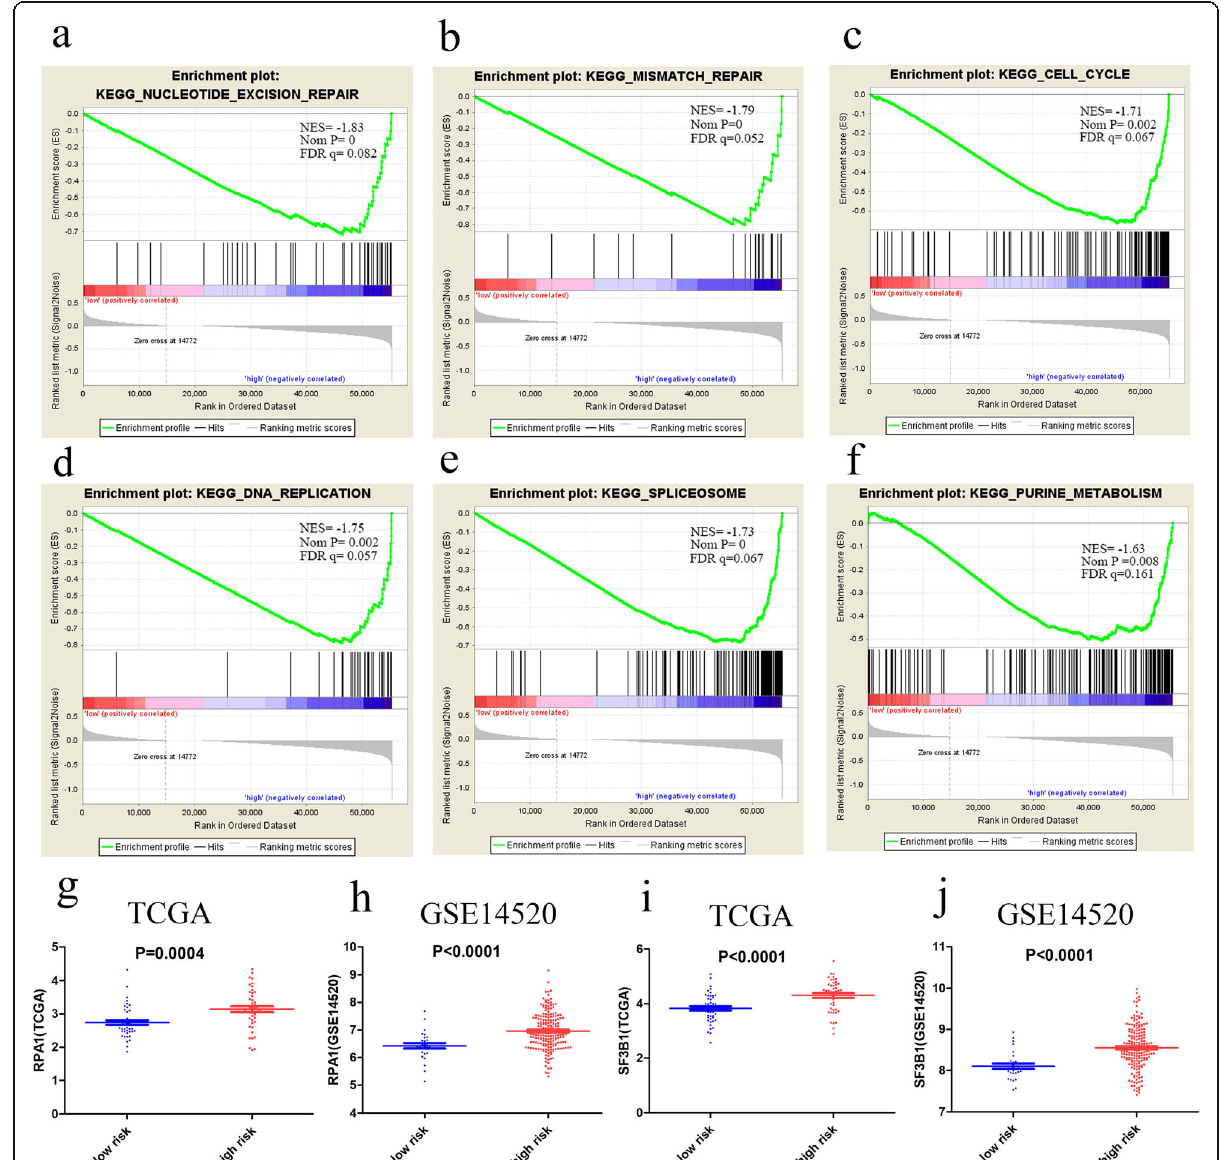
Fig. 6 KEGG pathways identified in the high-risk group; P < 0.05 and FDR q < 0.25 were considered significant ( a-f ). The expression of enriched genes in the different risk groups, based on the TCGA and GSE14520 datasets ( g-j ). (FDR, false discovery